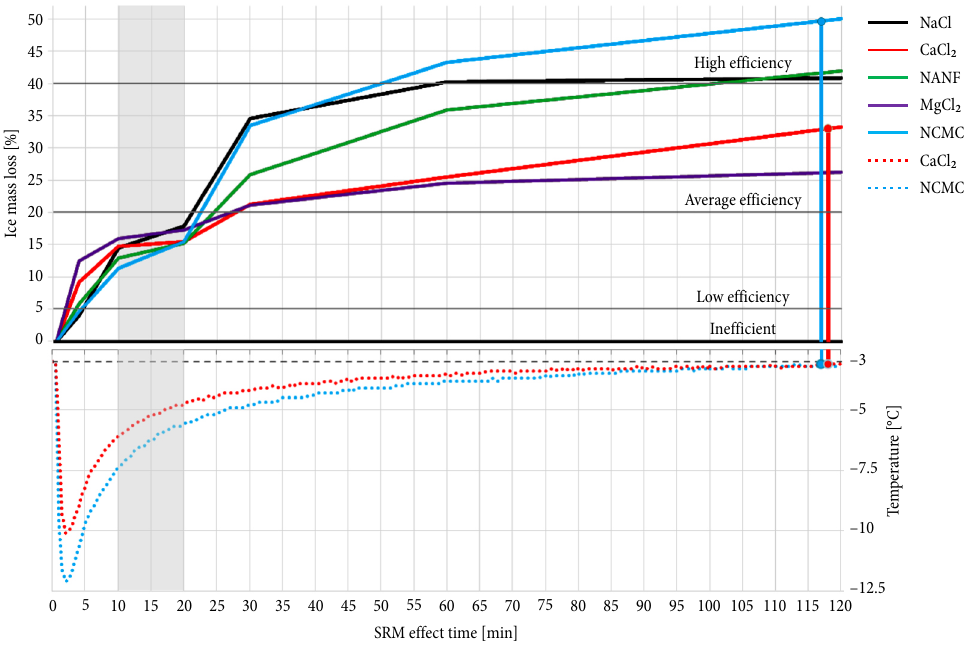
Fig. 1. Loss of ice mass and the change in surface temperature ( t = –3 °C) (Bulevičius et al.